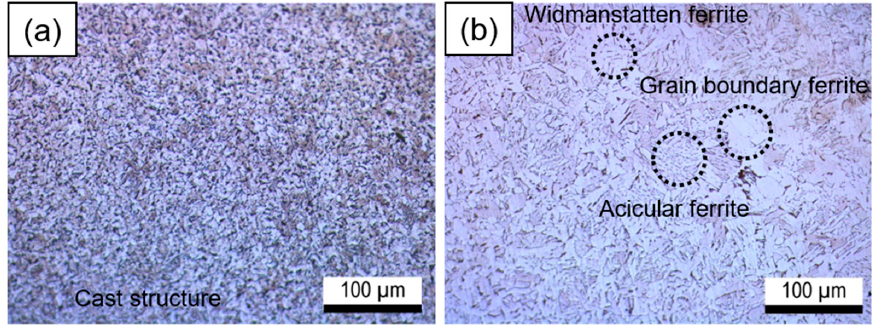
Figure 3. Optical micrographs of the weldment: ( a ) weld metal; ( b ) heat-affected zone.